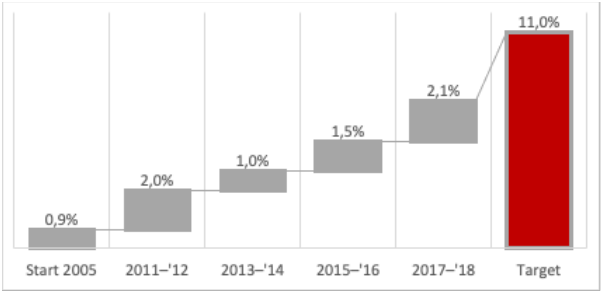
Figure 14. Luxemburg—energy consumption trend. Source: https://ec.europa.eu/eurostat/web/ energy/data/shares, accessed on 28 June 2021.